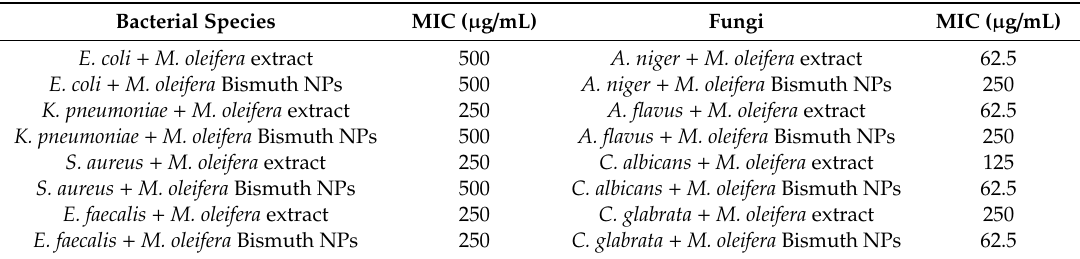
Table 6. Anti-bacterial activity (estimated MIC values) and anti-fungal activity (estimated MIC values). Bacterial